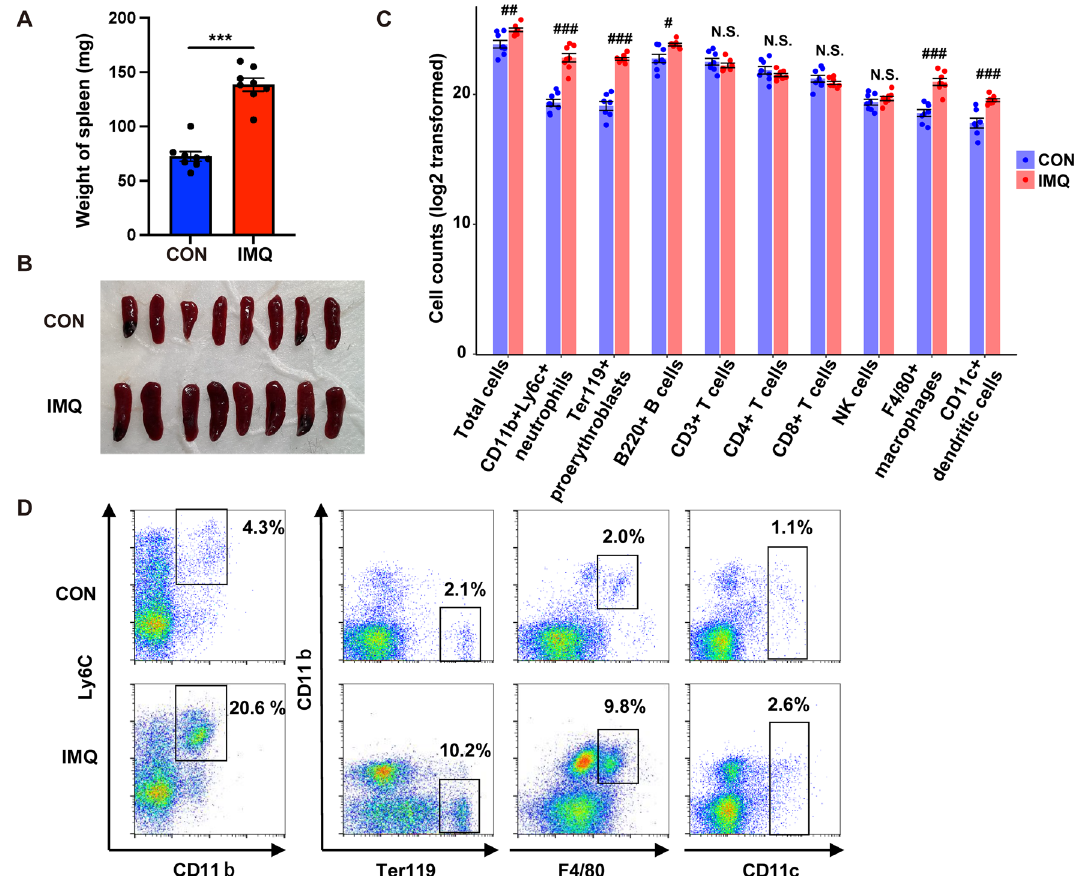
Figure 1. Effects of IMQ on weight and cell populations of spleen. ( A ): Spleen weight (Student t-test: df = 14, t = − 9.017, P = 0.000). ( B ): The photos of spleen from the control group and IMQ group. ( C ): FACS analysis of spleen samples from the two groups. Log2 transformed data of the number of total cells and each cell type. Total cells (Mann- Whitney test: U = 7, FDR-corrected P = 0.0079), CD11b + Ly6c + neutrophils (Mann-